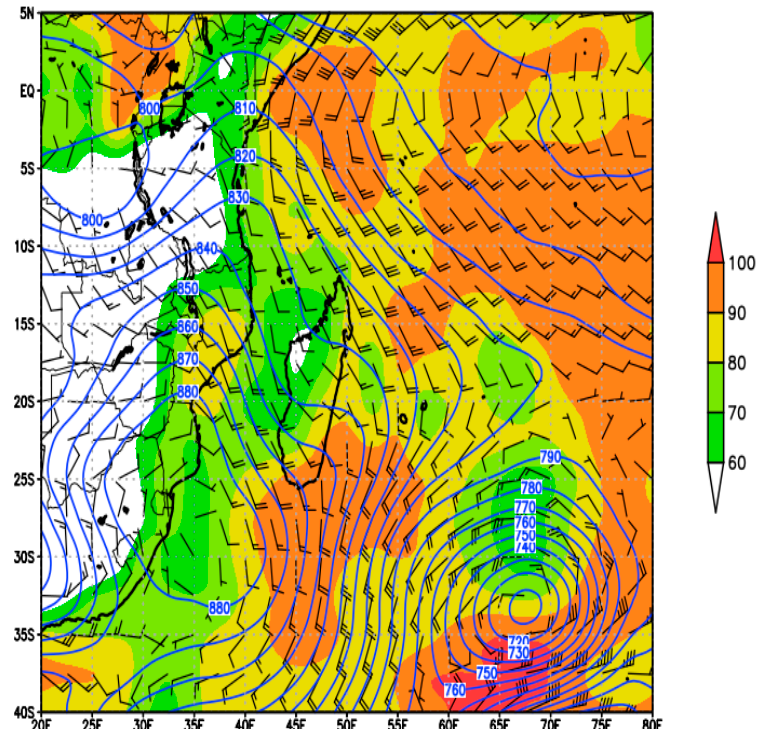
Figure 3. Map of the southern area of Africa showing 925 hPa geopotential height pattern overlaid on wind (KT) and relative humidity (RH) fields portraying the ridging high-pressure system on 22 July 2014. The colorbar represents RH (Image generated with GrADS using NCEP Reanalysis Data).